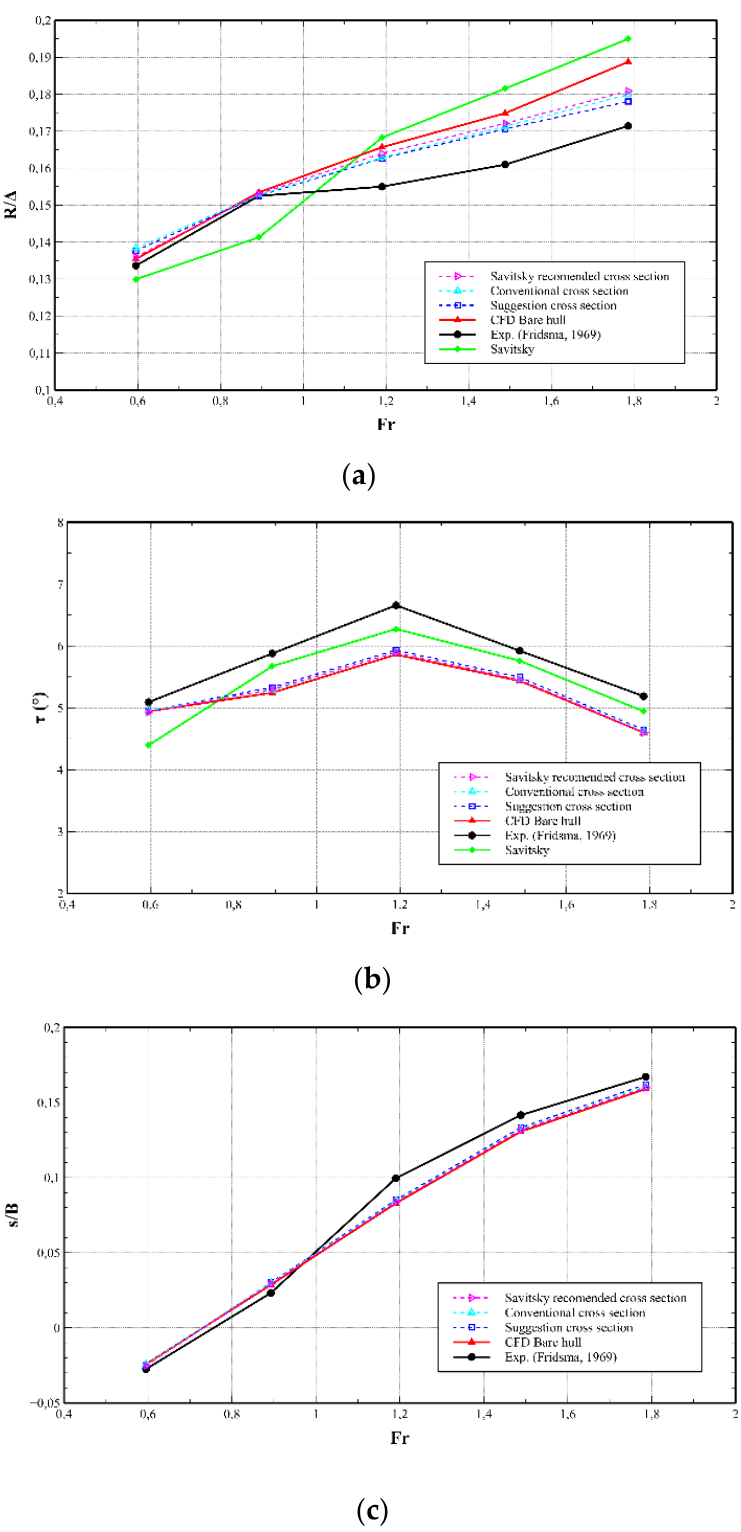
Figure 11. Comparison of the application of the cross-section shape ( a ) resistance; ( b ) trim; ( c ) heave.